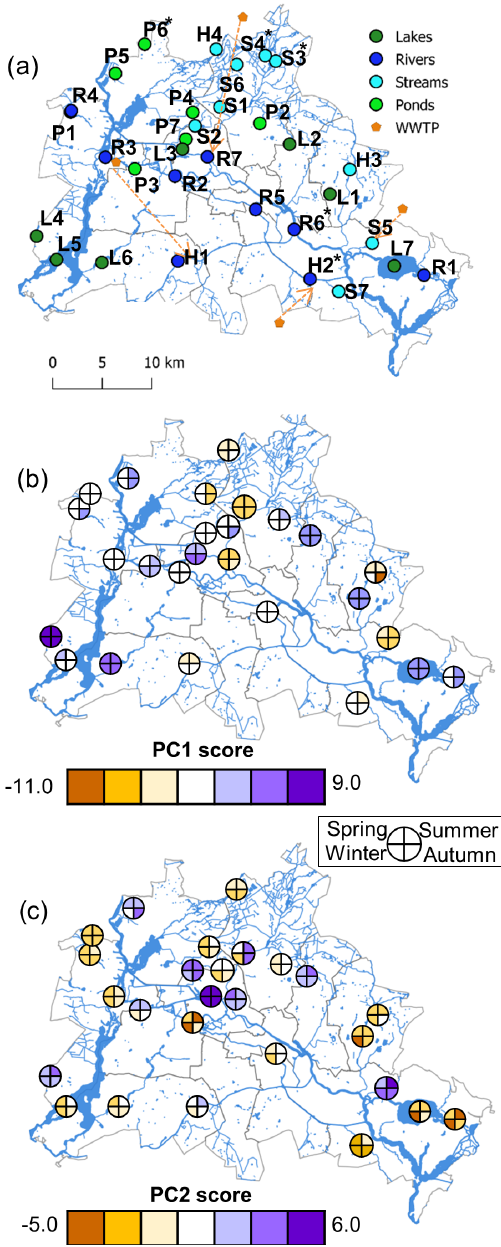
Figure 1. Map of 32 sampling sites in the city of Berlin, including 7 lakes (dark green), 7 ponds (light green), 9 streams (light blue) and 9 rivers (dark blue), in turn including 2 heavily polluted stream sites and 2 heavily polluted river sites. Wastewater treatment plants (WWTPs) are shown in orange; arrows point to locations where the effluents are discharged (a) . Scores of a principal component analysis (PCA) of DOM characteristics shown as color gradients for all sites sampled in four seasons (b, c) . The PCA is based on DOC concentrations, all absorbance and fluorescence data, absolute component-specific fluorescence intensities from PARAFAC, and data from size-exclusion chromatography. Different colors indicate differences in DOM composition. Site codes are given in Table S1. Sites marked by asterisks ( ∗ ) were restricted to three seasons and hence excluded from the